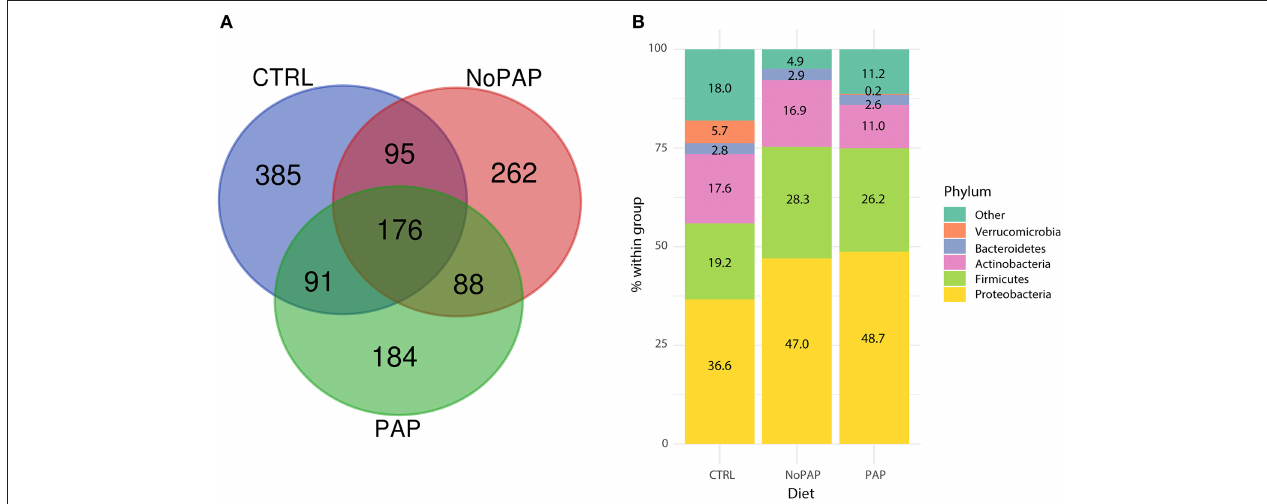
FIGURE 2 | (A) Venn diagram showing unique and shared operational taxonomic units (OTUs) in the intestines of fish fed with the three experimental diets. The 176 common OTUs represent 63.5, 69.4, and 60.5% of the overall microbiota in the CTRL, non-PAP, and PAP groups, respectively. Unique OTUs for the CTRL, non-PAP, and PAP groups represent 16.25, 11.8, and 7.3% of the overall bacterial composition, respectively. (B) Stacked bar chart representing the relative abundance of bacterial phyla in the three dietary groups. Only the phyla that are present in at least 1% in one of the groups are represented. No significant differences were found among the groups (Kruskal–Wallis + Holm–Sidak tests, P > 0.05).